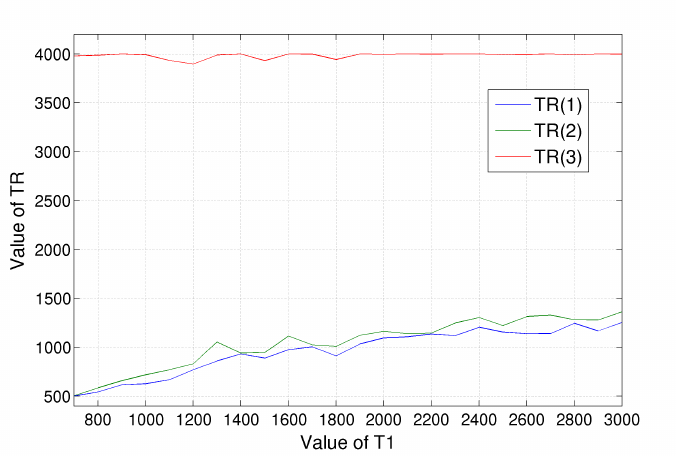
Figure 6. T values that minimize the CRLB of T R relaxation times, T . Three values have been considered: the red line is for the highest T 1 value, the blue line for the lowest one and green for the intermediate